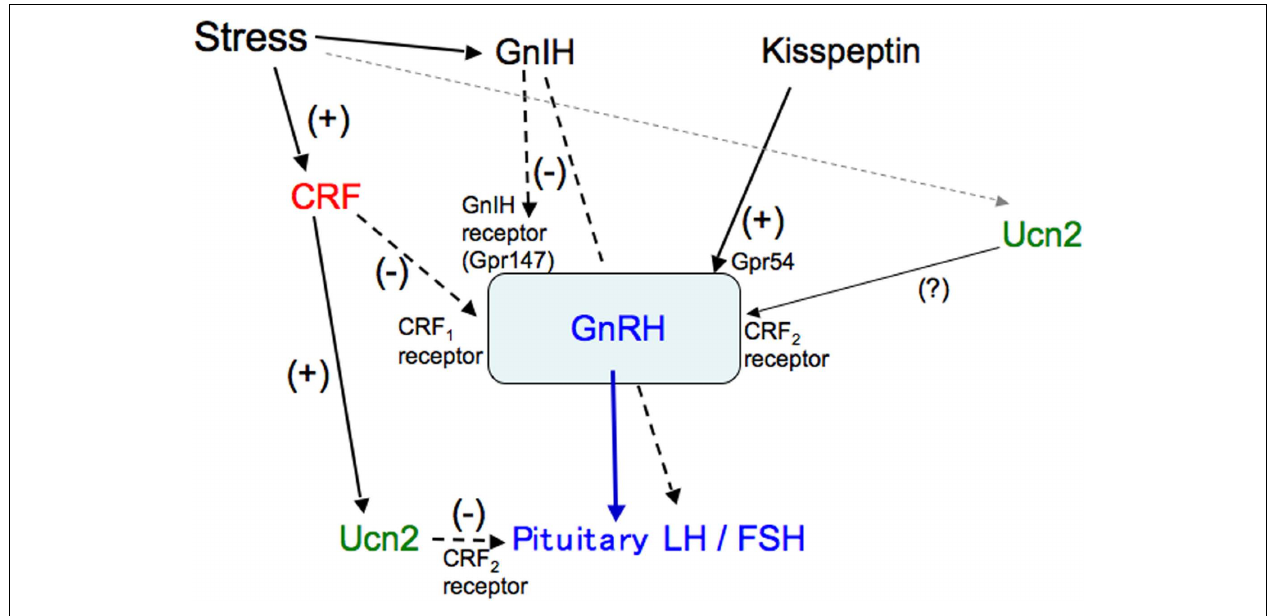
FIGURE 3 |A schematic model of the regulation of gonadotropins by CRF and Ucn. Stress-induced increases in CRF stimulate Ucn2 in corticotrophs, which inhibits gonadotropin secretion via the CRF 2 receptor in the pituitary.